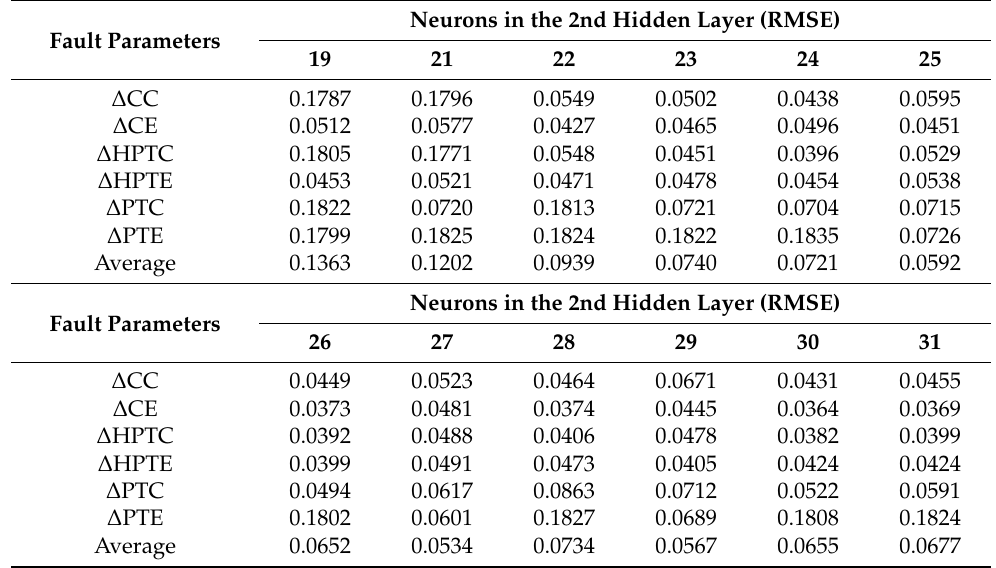
Table 6. Selection of the optimal neurons number (turbo shaft, extended